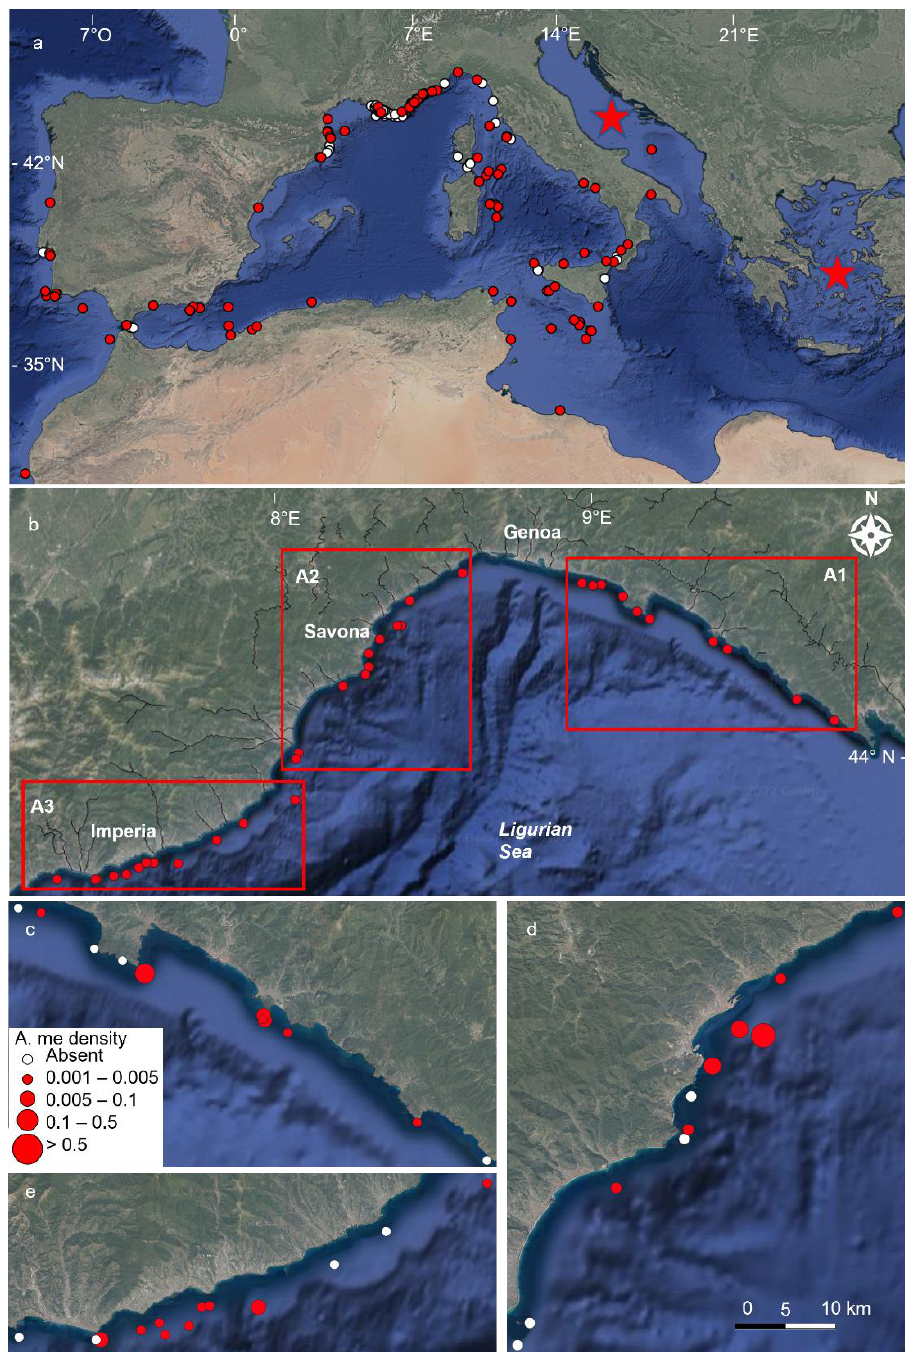
Figure 2. ( a ) Distribution of Astrospartus mediterraneus in the Mediterranean Sea and Atlantic wa- ters. Red circles, scientific papers; white spots, citizen science observations; red stars, presence without indication of geographic coordinates. ( b ) Map of the Ligurian Sea with indicated the stud- ied sites in the three macro-areas (A1, Eastern Liguria; A2, Central Liguria; A3, Western Liguria). ( c – e ) Enlargements of the three macro-areas. Red circles are sites with A. mediterraneus (the size of the circle is proportional to the density of the specimens); white circles are sites without recorded